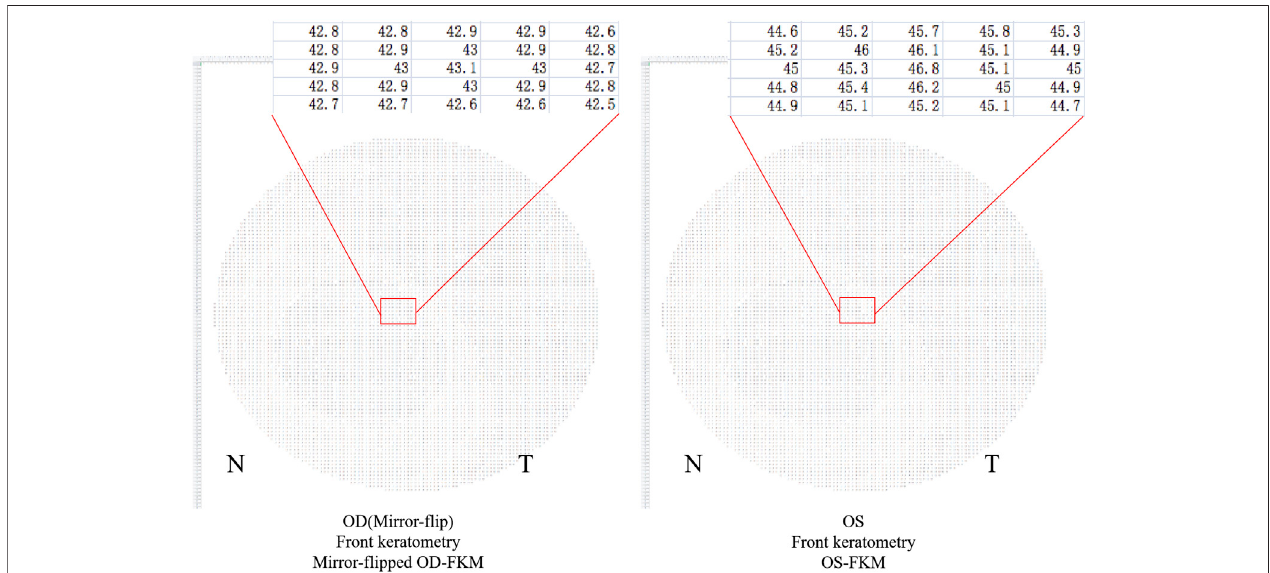
FIGURE 2 | Mirror- fl ipped OD-FKM established for calculation. The red box shows a part of raw data in the FKM.